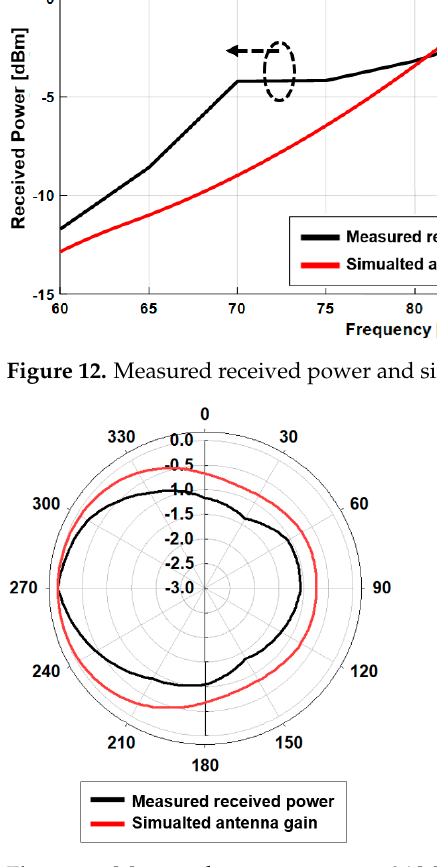
Figure 13. Measured power pattern at 86 MHz and simulated antenna gain pattern at 88 MHz.